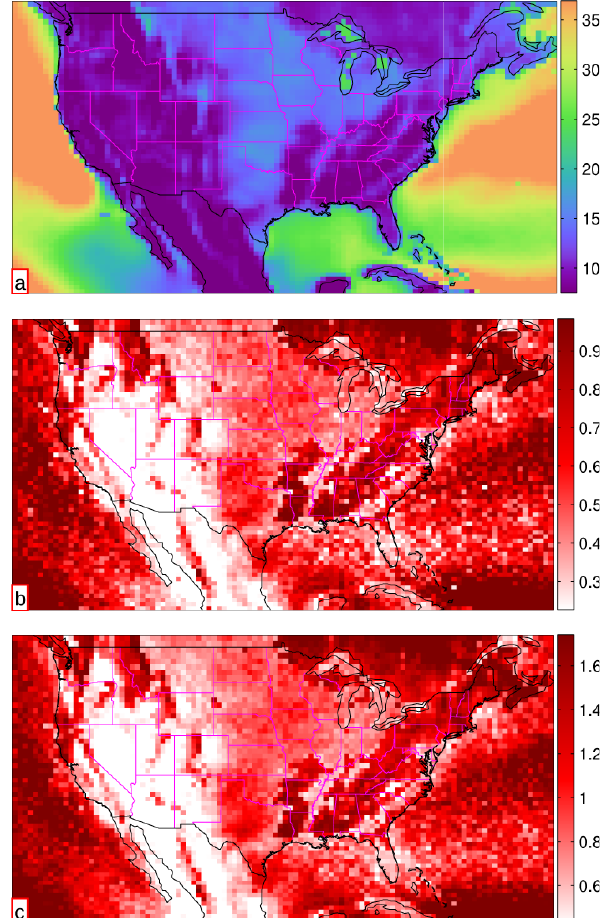
Fig. 14. Variation of mean WPD episode lengths (h) at different heights. (a) shows mean wind power episode length at 80m and, (b) and (c) show the difference WPD episode length at 100m and 120m from that at